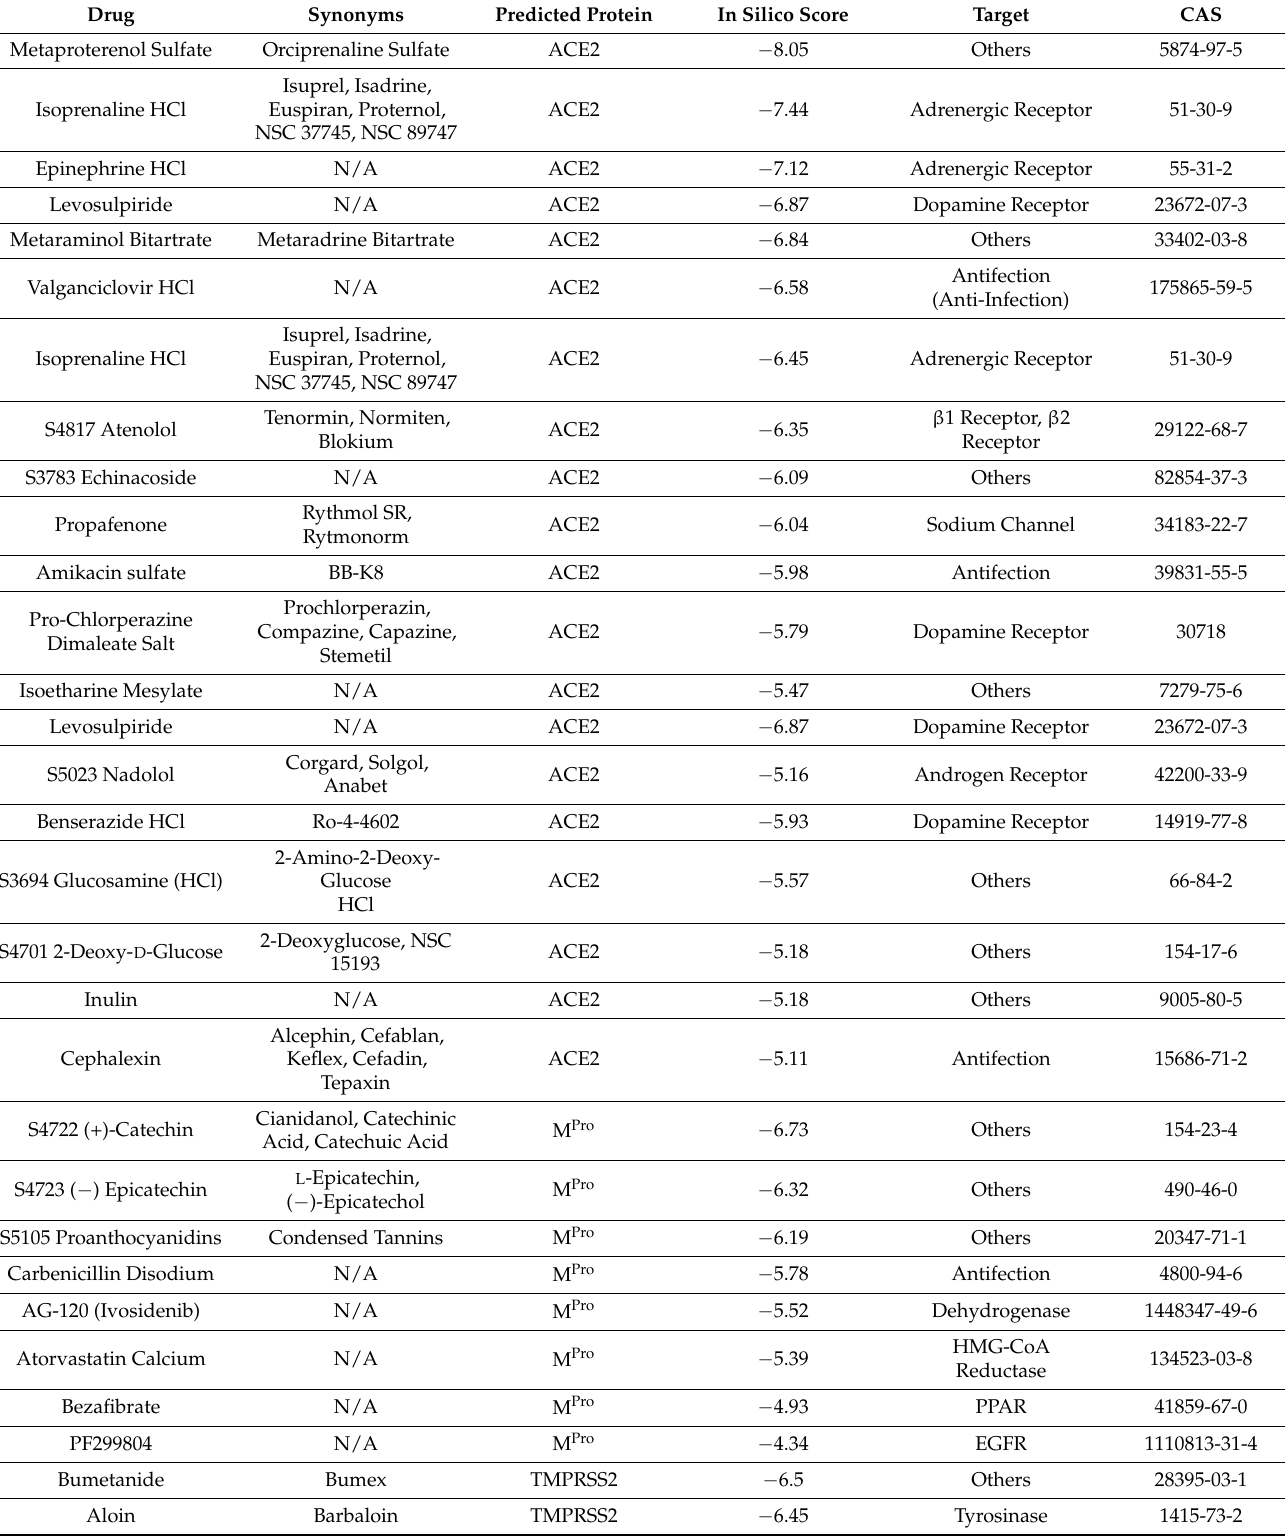
Table 1. Top 40 FDA predicted compounds for ACE2–S protein, M Pro , and